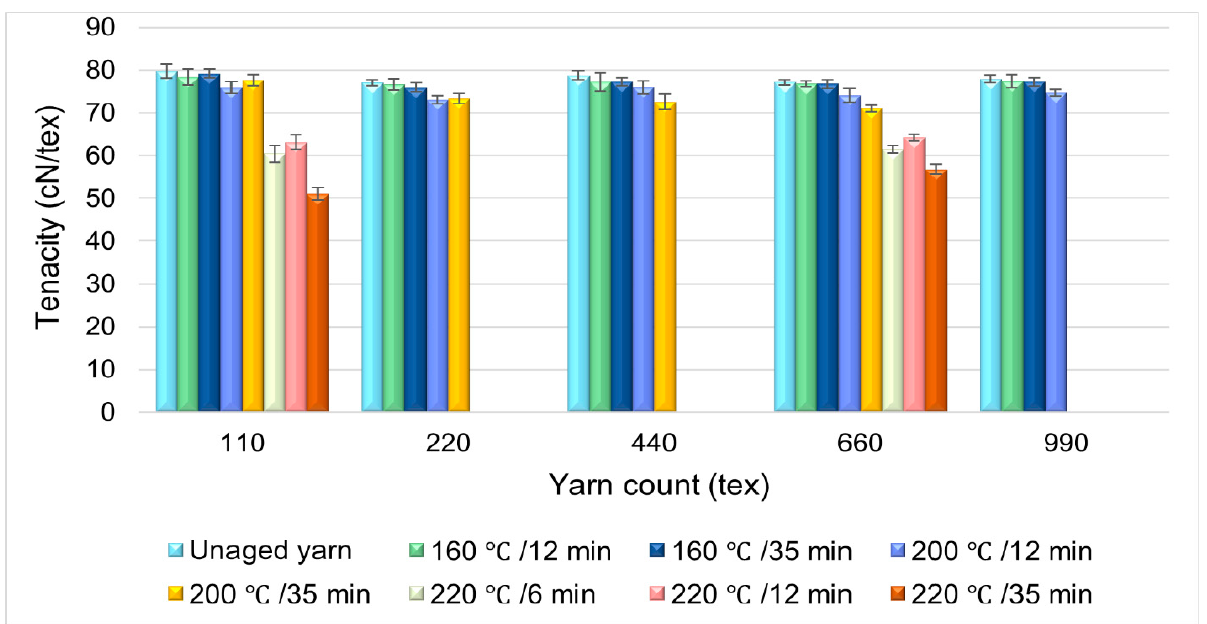
Figure 7. Effect of aging time on the tenacity of HT polyester